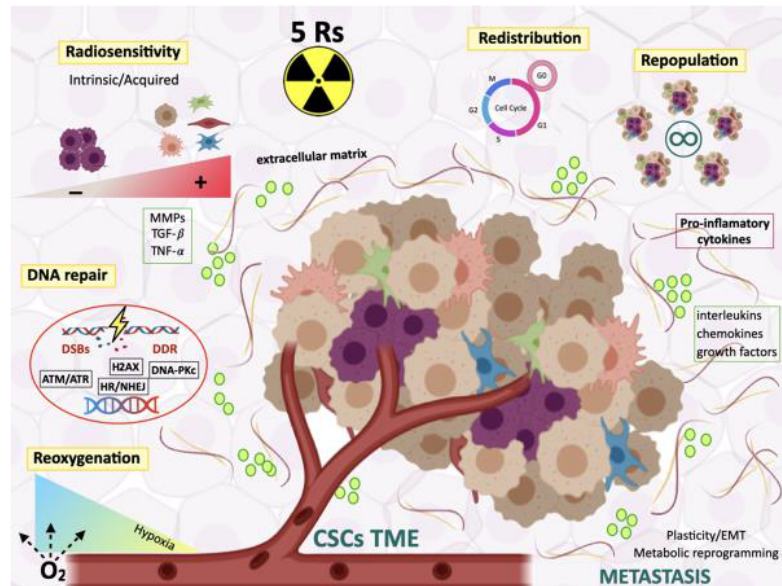
Figure 2. The five Rs of radiation biology and the tumor microenvironment influence on tumor response to radiotherapy. Radiation-induced DNA damage, such as double-strand breaks (DBSBs) trigger a DNA damage response. Three kinases (ATM, ATR, and DNA-PKc) phosphorylate the H2AX histone that plays an essential role in the response to ionizing radiation. Radiosensitivity: intrinsic and acquired radioresistance of cancer cells and particularly of CSCs is important to determine the outcome to radiotherapy. Repair mechanisms of sublethal damage after radiation exposure involve homologous repair (HR) and non-homologous end joining (NHEJ). Repair takes place after cell cycle blockage mediated by ATM, ATR, CHK1, and CHK2, among others. Redistribution of cells in the cell cycle a ff ects their radioresistance. Cells in the late-S phase are more resistant and cells in the G2 / M-phase are more sensitive to radiation. The time between two fractions allows resistant cells in the S-phase to redistribute into phases where cells are more radiosensitive. Repopulation: CSCs not eradicated by irradiation are involved in the accelerated repopulation of the tumor. Reoxygenation: cells in hypoxic niches within the tumor are more radioresistant. Reoxygenation between radiation fractions is important to increase tumor cell killing, which contributes to radiosensitization of hypoxic areas increasing the e ffi cacy of the radiation treatment. Radiotherapy induces the production of pro-inflammatory cytokines and other molecules (growth factors, metalloproteases -MMPs-, TNF α , TGF- β , interleukins, etc.) in the tumor microenvironment that are involved in the interaction between CSCs and their niche and between CSCs and non-CSCs determining CSC radiosensitivity. CSC metabolic reprogramming associated to cell plasticity and epithelial to mesenchymal transition process is involved in metastasis. In CSCs having extensive cell plasticity, niche signals will reinstruct stem cell properties to progenitor or di ff